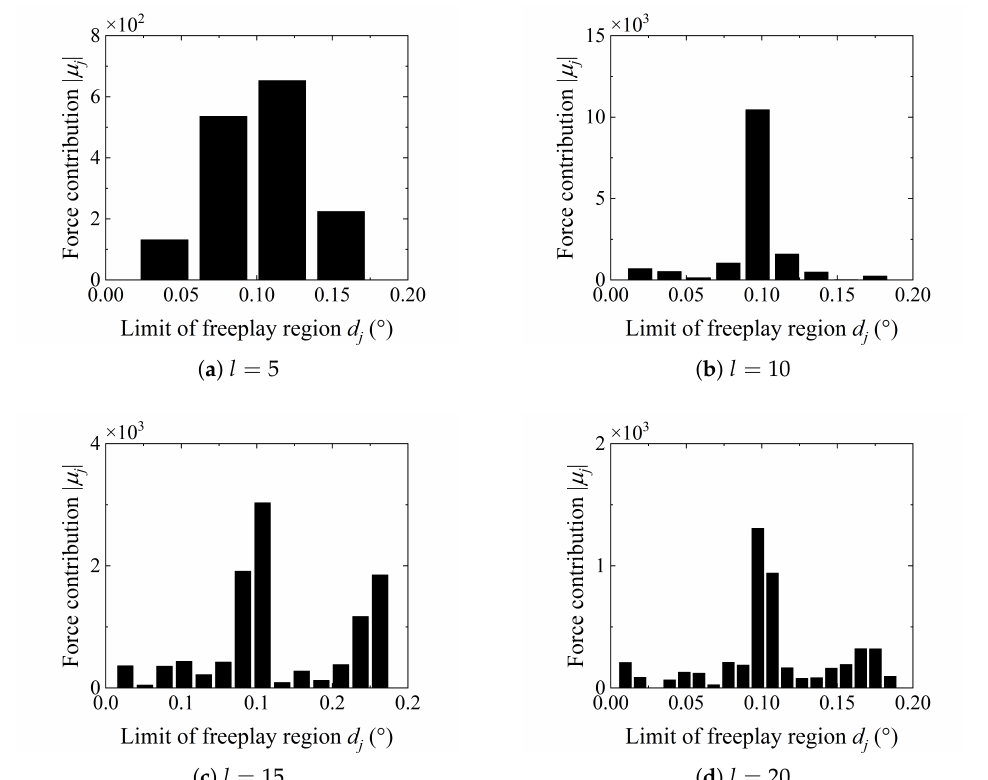
Figure 7. The estimation of the nonlinear contribution of central freeplay using the 1st displacement range [ 0,max ( q r )]